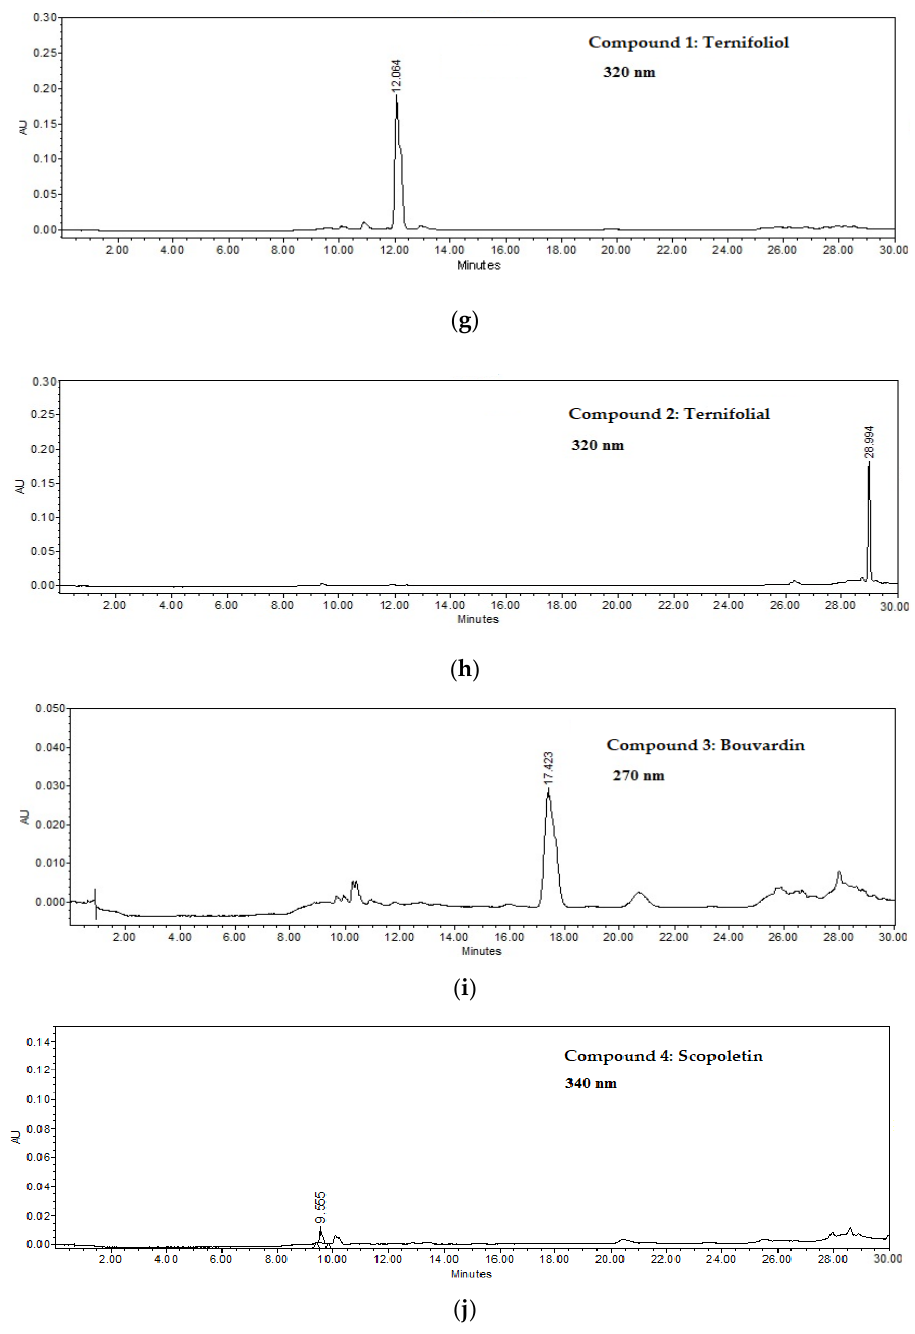
Figure 1. Chromatographic profiles obtained by HPLC of the extracts, fractions, and compounds obtained from the root of Bouvardia ternifolia : ( a ) Bt-AcOEt (270 nm); ( b ) Bt-Aq (270); ( c ) M1(320); ( d ) M2 (270); ( e ) M3 (270); ( f ) M4 (270); ( g ) ternifoliol ( 1 ) (12.064 min; ( h ) ternifolial (2) 28.994 min; ( i ) bouvardin ( 3 ) 17.423 min; ( j ) scopoletin ( 4 ) (9.55 min).